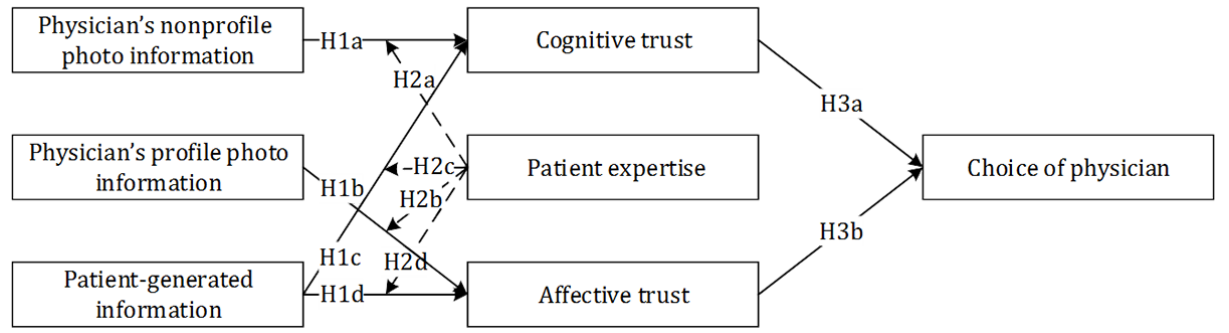
Figure 1. Research model explaining the influence of physician information on the patients’choice of physician in mHealth. H1a: hypothesis 1a; H1b: hypothesis 1b; H1c: hypothesis 1c; H1d: hypothesis 1d; H2a: hypothesis 2a; H2b: hypothesis 2b; H2c: hypothesis 2c; H2d: hypothesis 2d; H3a: hypothesis 3a; H3b: hypothesis 3b.